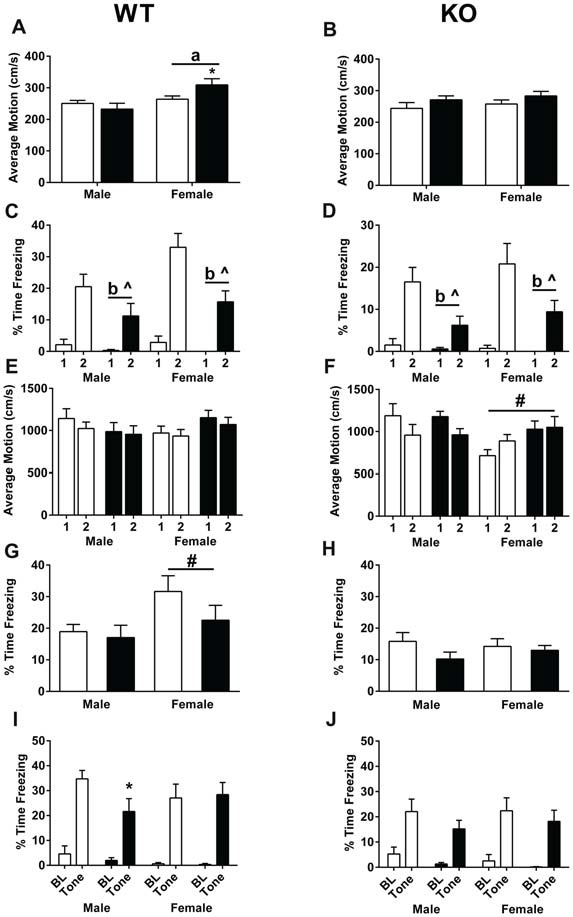
Fear learning and memory of saline- and MPTP-treated WT (A,C,E,G,I) and KO (B,D,F,H,J) mice. (A) In WT mice, females showed higher activity than males during the baseline period (prior to the first tone). ap = 0.003. In addition, MPTP increased activity levels in females (*p = 0.035) but not males. (B) No sex or MPTP treatment effects were seen in KO mice. (C,D) WT and KO mice demonstrated learning of the tone-shock pairing, indicated by the higher time spent freezing during tone 2 compared to tone 1. WT: p < 0.001; KO: p < 0.001. Furthermore, MPTP treatment in both genotypes resulted in less freezing during the tone (WT: bp = 0.001; KO: bp = 0.007) as well less of an increase in freezing going from tone 1 to tone 2 (WT: ^p = 0.0012; KO: ^p = 0.007). (E) This was not due to a differential response to the shock in WT mice. (F) In KO mice, females did not show a similar decrease in average motion during shock 2 compared to shock 1 as seen in males. #p < 0.001. (G) During the contextual fear memory test, WT females spent more time freezing than WT males. ap = 0.031. (H) No sex differences in contextual fear memory were seen in KO mice. (I) In WT mice, MPTP impaired cued fear memory in males, but not females. *p = 0.0415. (J) MPTP did not affect cued fear memory in KO male or female mice. ^ refers to interactions between treatment and tone; b refers to a significant treatment effect.